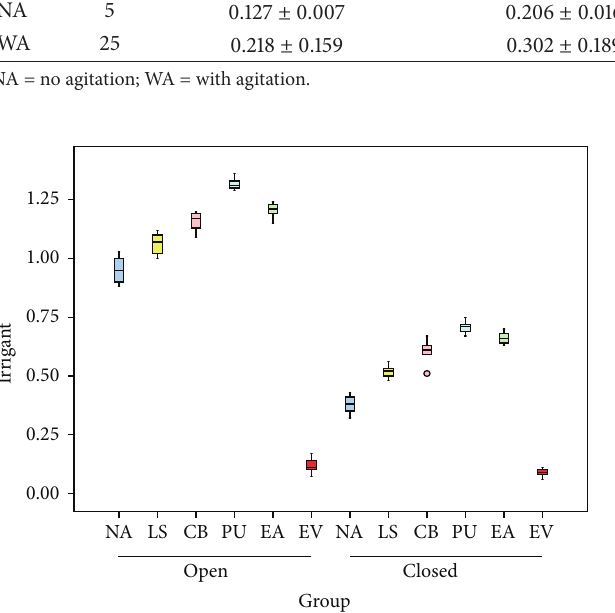
Figure 2: Box diagram showing amount of irrigant extruded in mL in different groups. Data are presented as mean and standard